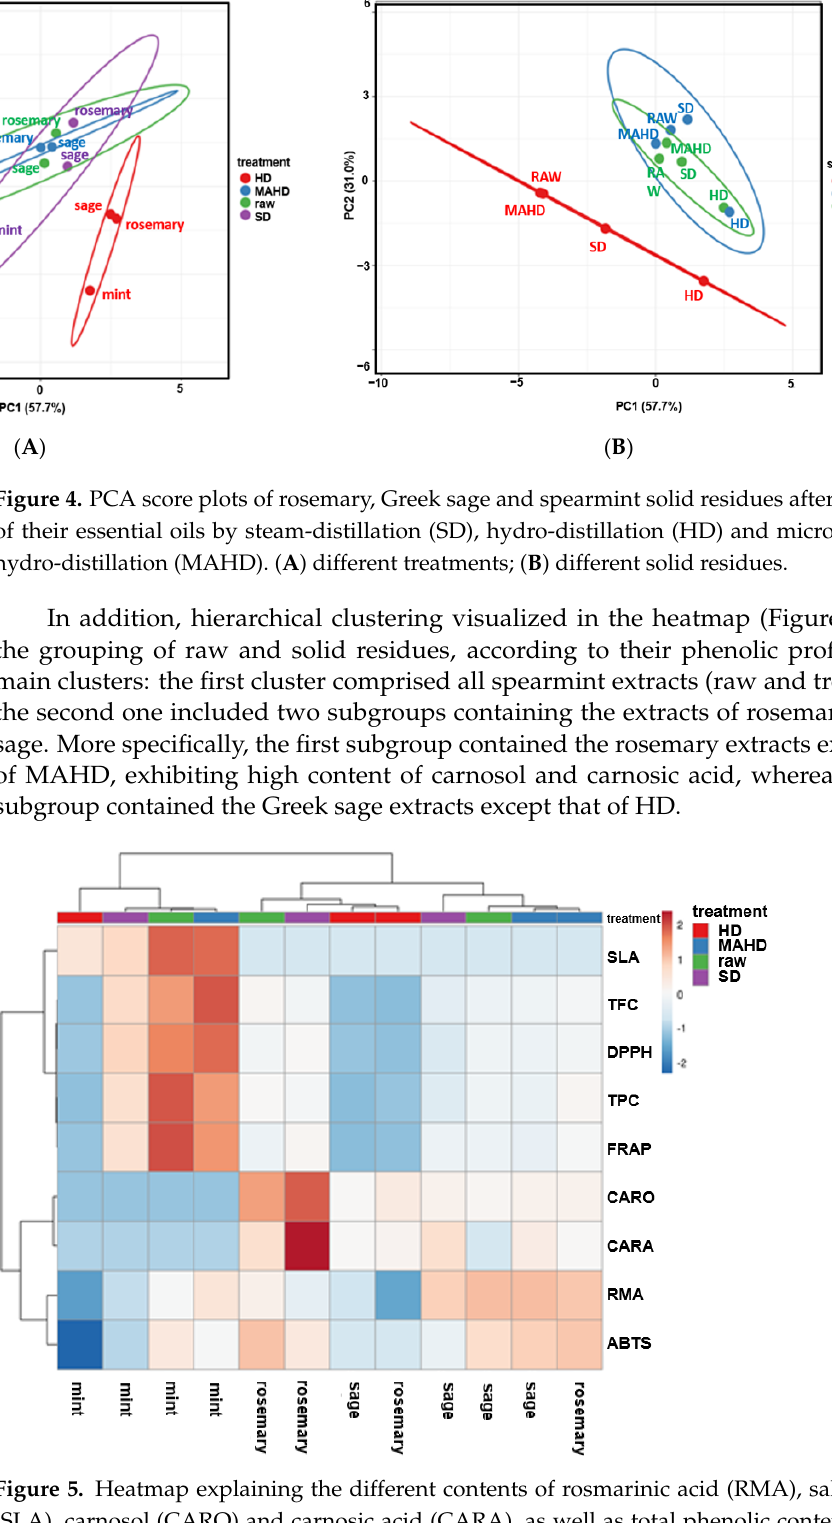
Figure 5. Heatmap explaining the different contents of rosmarinic acid (RMA), salvianolic acids (SLA), carnosol (CARO) and carnosic acid (CARA), as well as total phenolic content (TPC), total flavonoid content (TFC) and antioxidant activity as estimated by DPPH, ABTS and FRAP assays of rosemary, Greek sage and spearmint extracts of solid residues remaining after the extraction of their essential oils by steam-distillation (SD), hydro-distillation (HD) and microwave-assisted hydro-distillation (MAHD).